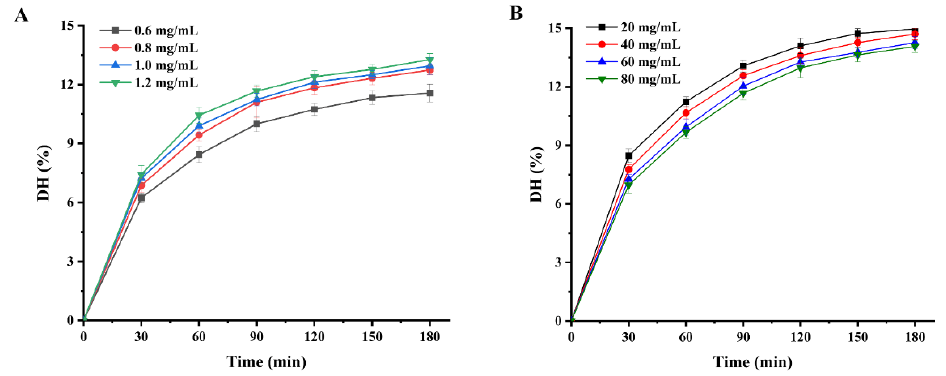
Figure 2. Enzymatic profiles of WPI hydrolysis by Alcalase protease: ( A ) degree of hydrolysis of WPI at different Alcalase protease concentrations; ( B ) DHs of WPI at different substrate concentrations. The values of the kinetic parameters a and b were calculated by Equation (21) and the results are shown in Table 2. The experimental data show that the value of a is not a constant but has a good linear relationship with E 0 /S 0 , followed by a = 24.85 (E 0 /S 0 ) + 0.31 (R 2 = 0.9929). Parameter b fluctuates only within a small range, so the average value of 0.269 is taken as b. Substituting the values of parameters a and b into Equation (21), the equation of DH was obtained as: DH = 3.72 ln [1 + (6.68 E 0 /S 0 + 0.08) t]. Table 2. Parameters a and b at different initial substrate concentration and enzyme concentration. S 0